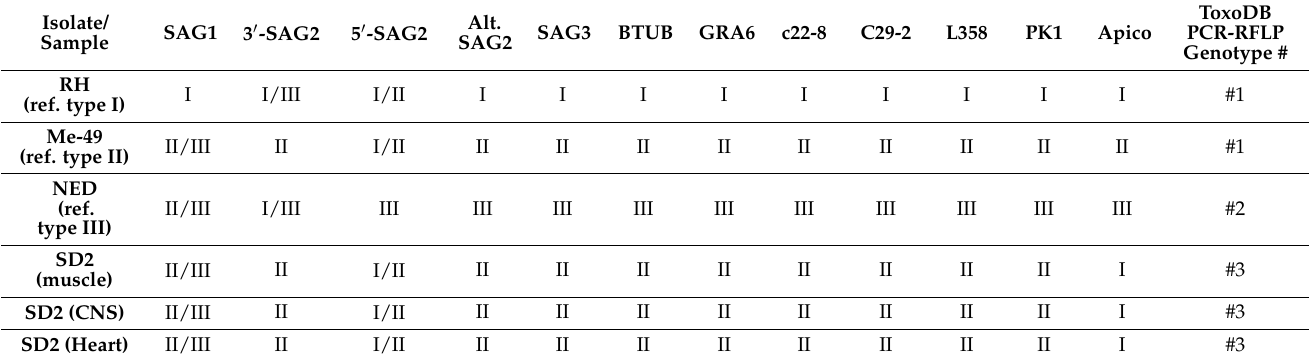
Table 2. Results of genotyping analysis carried out on Toxoplasma gondii strain identified in dolphin SD2. Isolate/